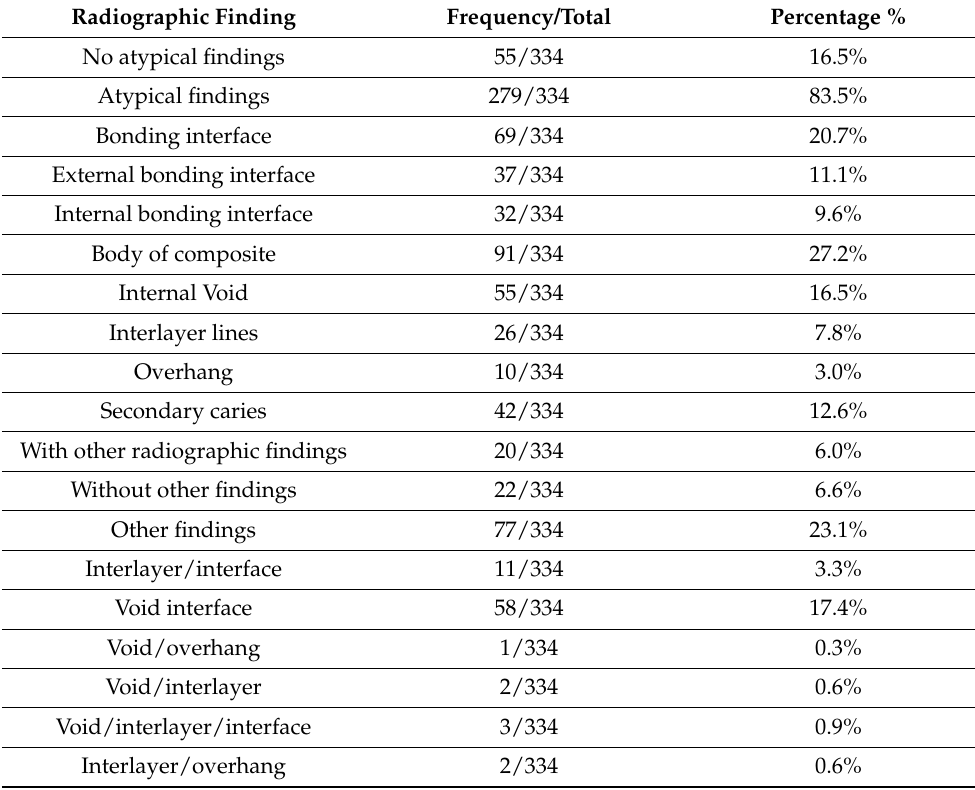
Table 2. The prevalence of radiographic abnormalities found in class II composite